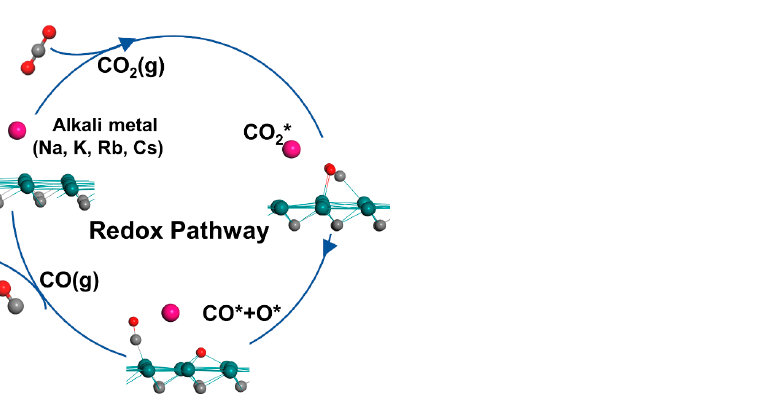
Figure 3. Schematic mechanism diagram of redox pathway in the RWGS reaction. The species with asterisks (*) represent adsorbed species.